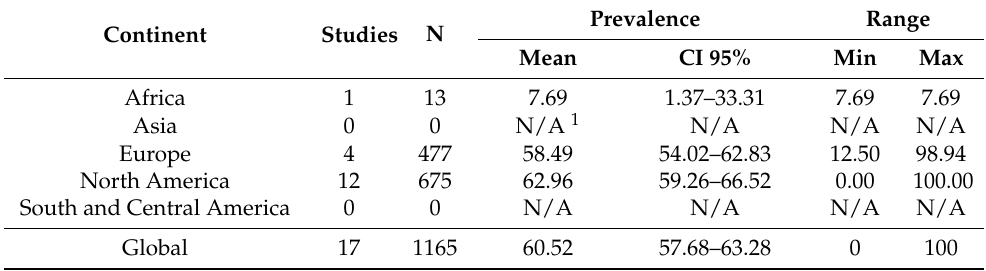
Table A6. Flock SLRV prevalence in each continent from 1981 to 1990.